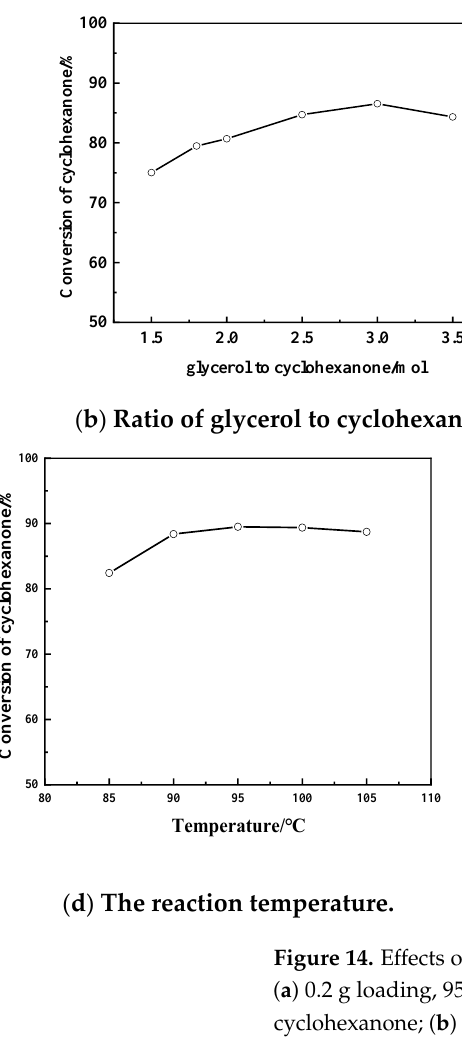
( a ) The reaction time.